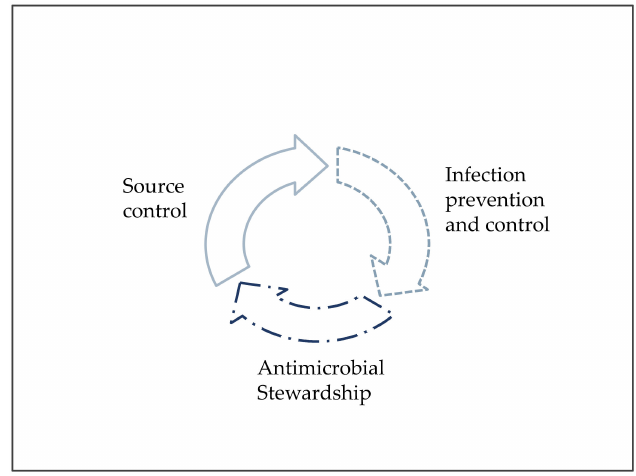
Figure 1. The three pillars of patient care against infections and antimicrobial